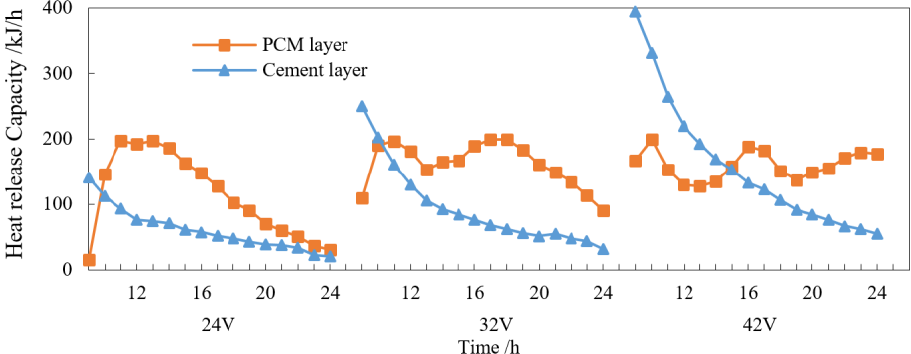
Figure 17. Heat release comparison of layer V between the two wallboards.